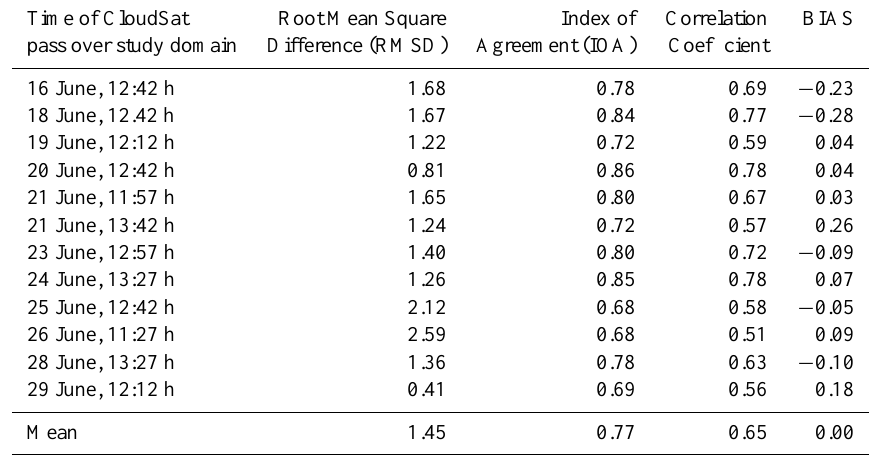
Table 1. Error Statistics between estimated SCOT from SEVIRI and SCOT from CloudSat. Time of CloudSat Root Mean Square Index of Correlation BIAS pass over study domain Difference (RMSD) Agreement (IOA) Coefficient 16 June, 12:42 h 1.68 0.78 0.69 −